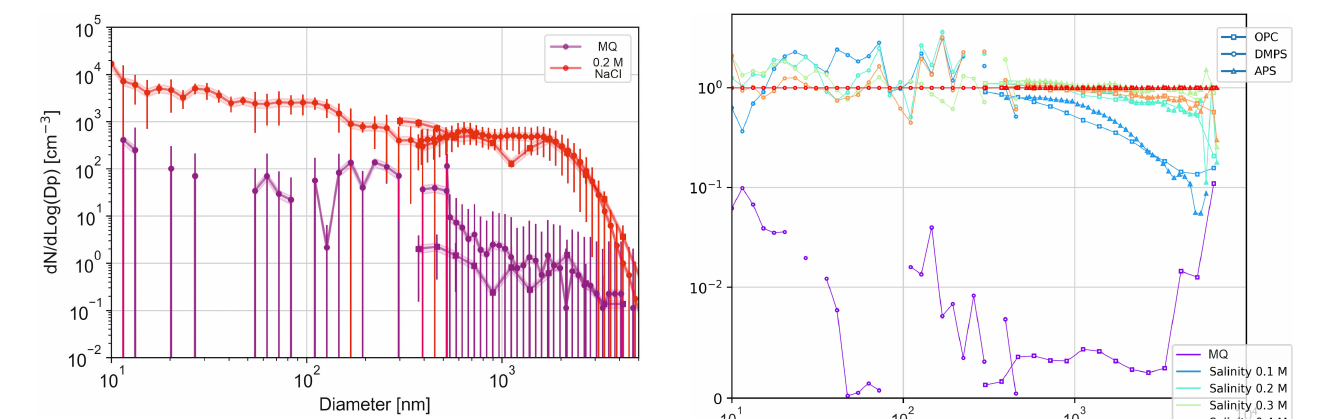
Figure 5. Aerosol size distribution for MQ water (lilac markers) bubbled at 0.8Lmin − 1 and 0.2M NaCl-solution (red markers) bub- bled at 0.8Lmin − 1 , as measured with the DMPS (circles), APS (circles), and OPS (rectangles). Shading indicates pm 20% devi- ation and is based on a measured uncertainty range of the system using MQ water only. Error bars show the measured standard devi- ation during the experiments.